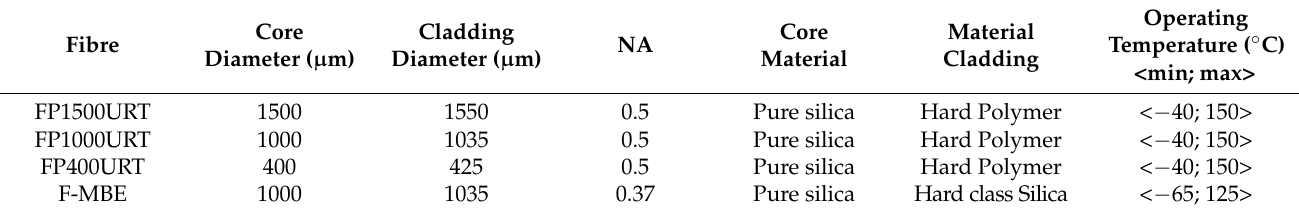
Table 2. Overview of the properties of the optical fibres